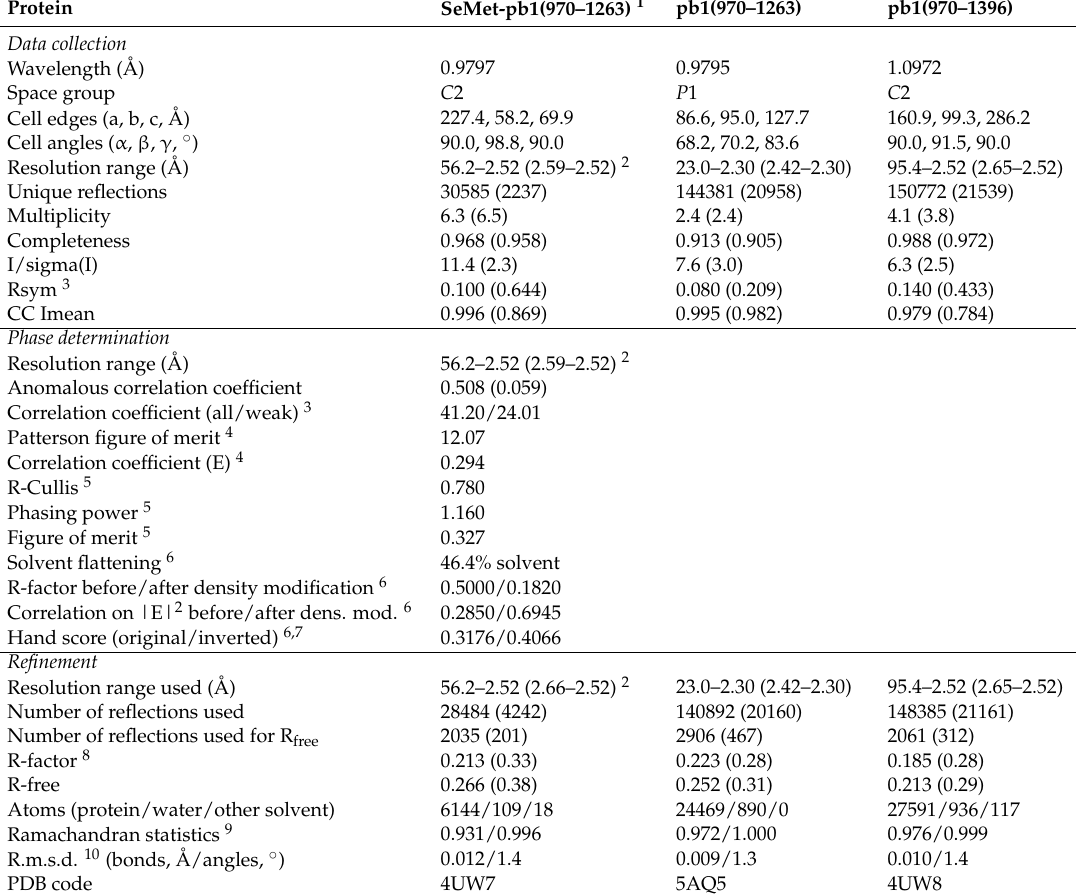
Table 1. Data collection, crystallographic phase determination and refinement